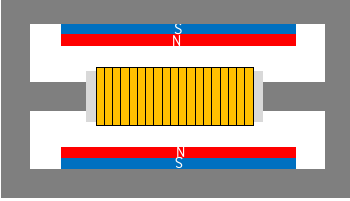
Figure 5. Structure of VCM.